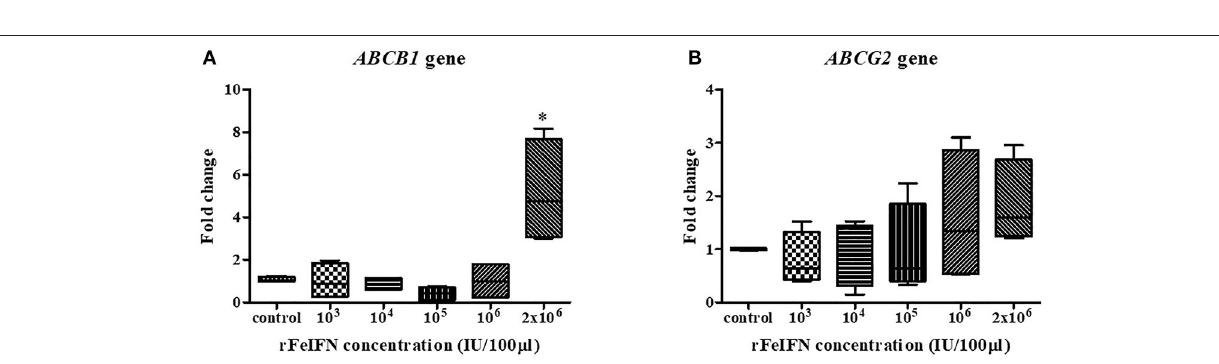
FIGURE 3 | Box plot showed the relative mRNA expression of ABCB1 (A) and ABCG2 (B) gene of primary CTVT culture at 72-h after incubation with varied concentrations of rFeIFN- ω (* p <